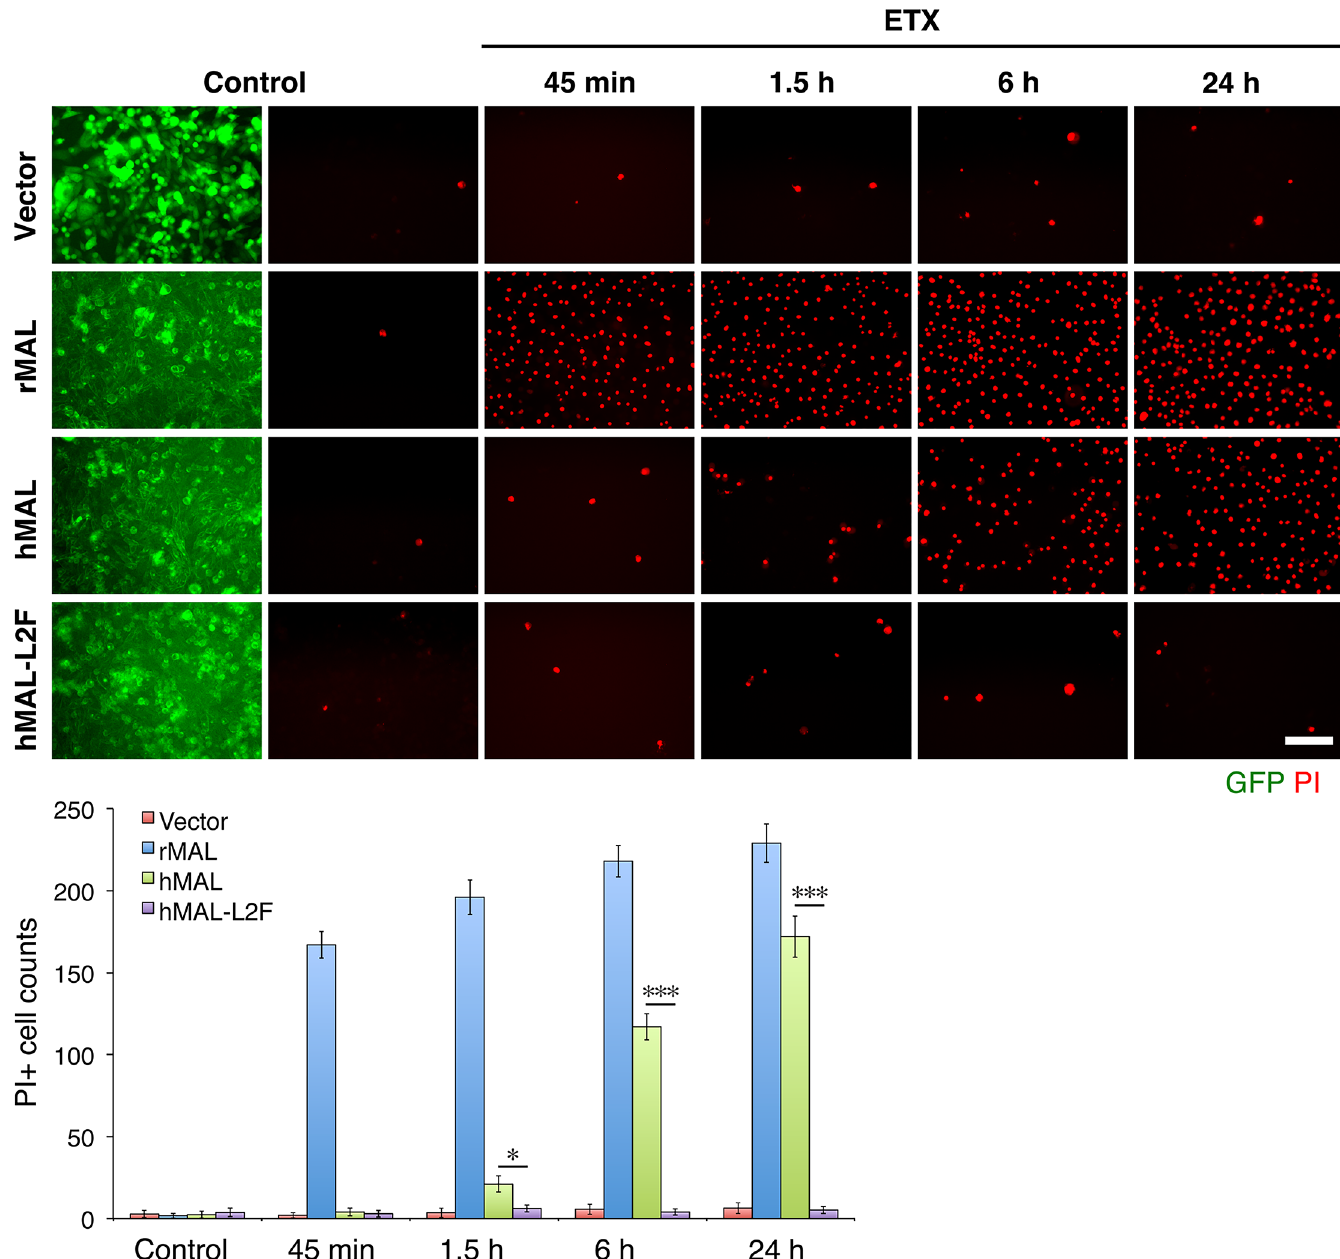
Fig 6. The second extracellular loop in MAL is critical to MAL-mediated ETX-cytoxicity. Representative images (top panels) and statistical analysis (bottom panel) show that MAL expression renders cells sensitive to ETX-induced cell death in rat MAL (rMAL)-expressing or human MAL(hMAL)-expressing CHO cells, whereas insertion of a FLAG segment in loop 2 of hMAL (hMAL-L2F) blocks hMAL-mediated ETX-cytotoxicity. CHO cells were treated with PBS (control) or 50 nM ETX and fixed at the indicated time points. 2 μ g/ml PI (red) were included in the culture medium to monitor cell death. Similar levels and patterns of GFP expression (green) in untreated (control) hMAL and hMAL-L2F cells suggest blockade of ETX-toxicity in the latter cells is a consequence of structural alteration resulting from Flag insertion in loop 2. Scale bar represents 100 μ m. Data are means and SD from a single experiment and are representative of three independent triplicate